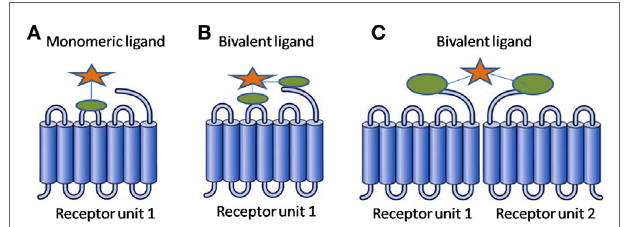
FiGURe 1 | Binding modes for a ligand (A) monovalent ligand with one receptor unit (B) bivalent ligand with one receptor unit (C) bivalent ligand with receptor